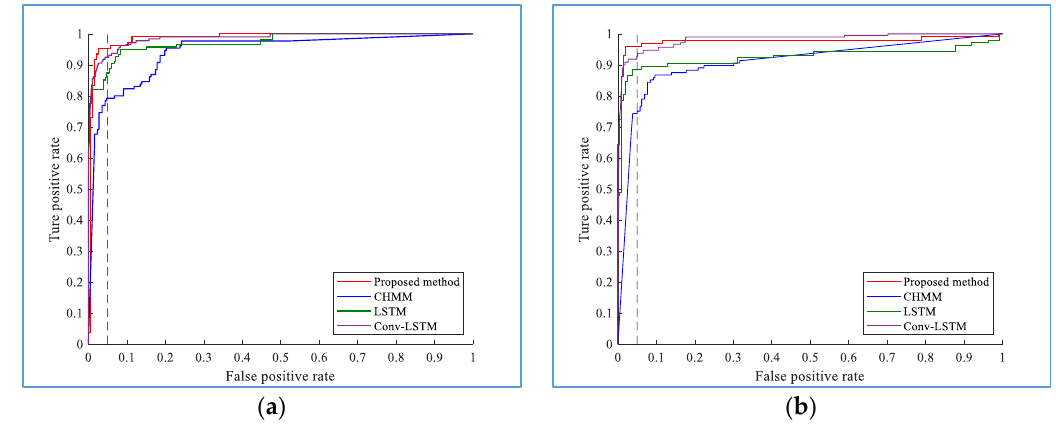
Figure 15. Receiver operating characteristic (ROC) curves for TL ( a ) and TR ( b ) based on the continuous hidden Markov model (CHMM) and the proposed hybrid algorithms at time t s . The dashed line shows the true positive rate around a false positive rate of 5%.